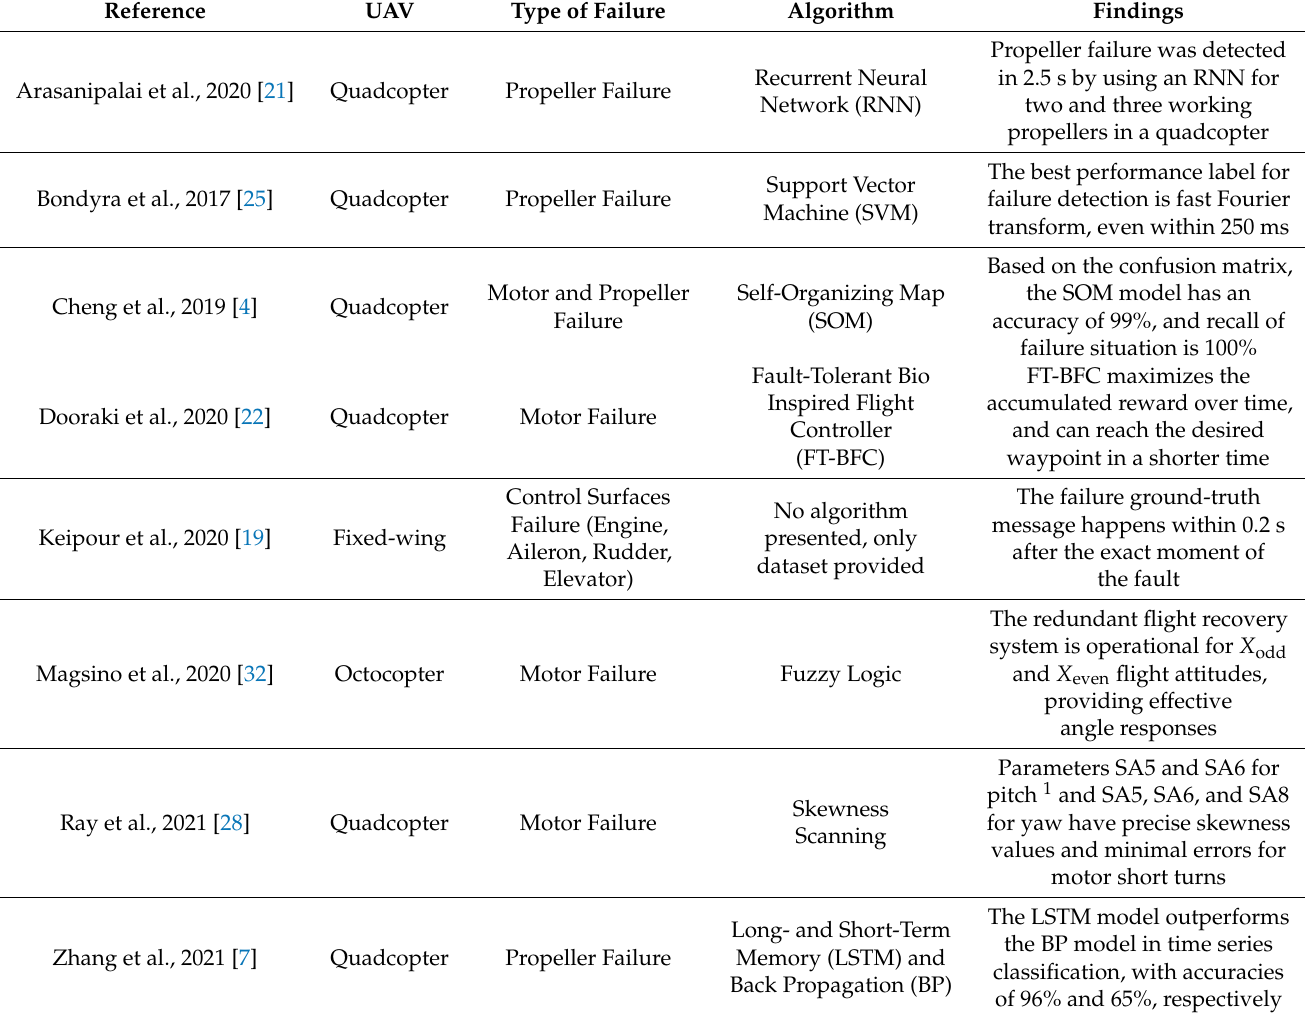
Table 1. Comparison of Failure Detection Types with Related